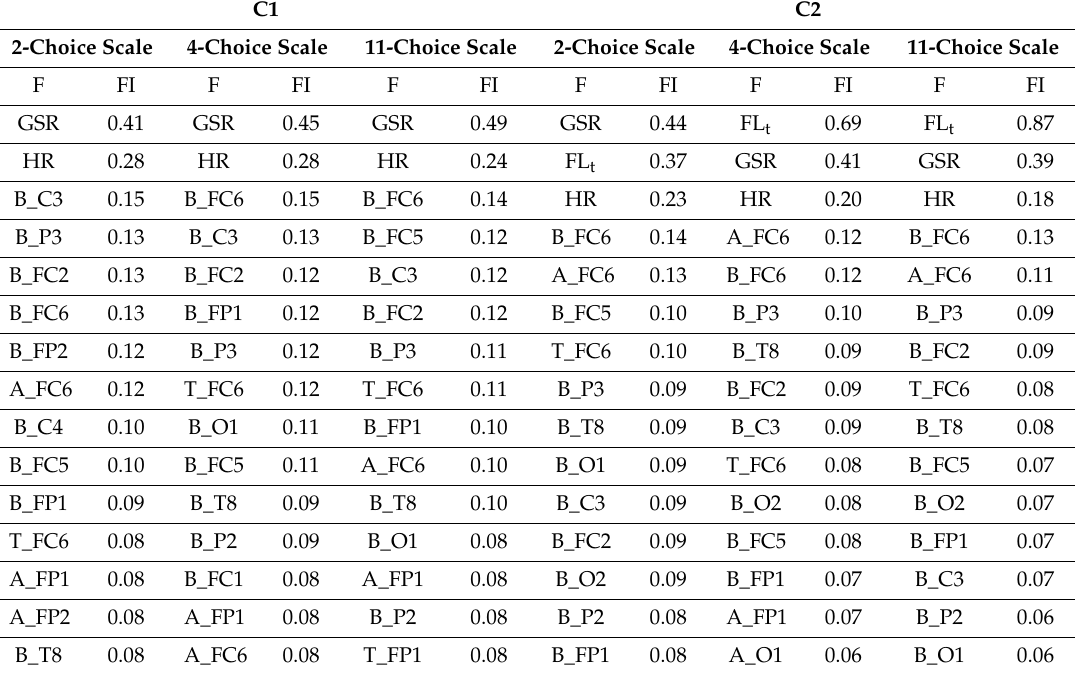
Table 8. Feature (F) and feature importance (FI) for the player-independent